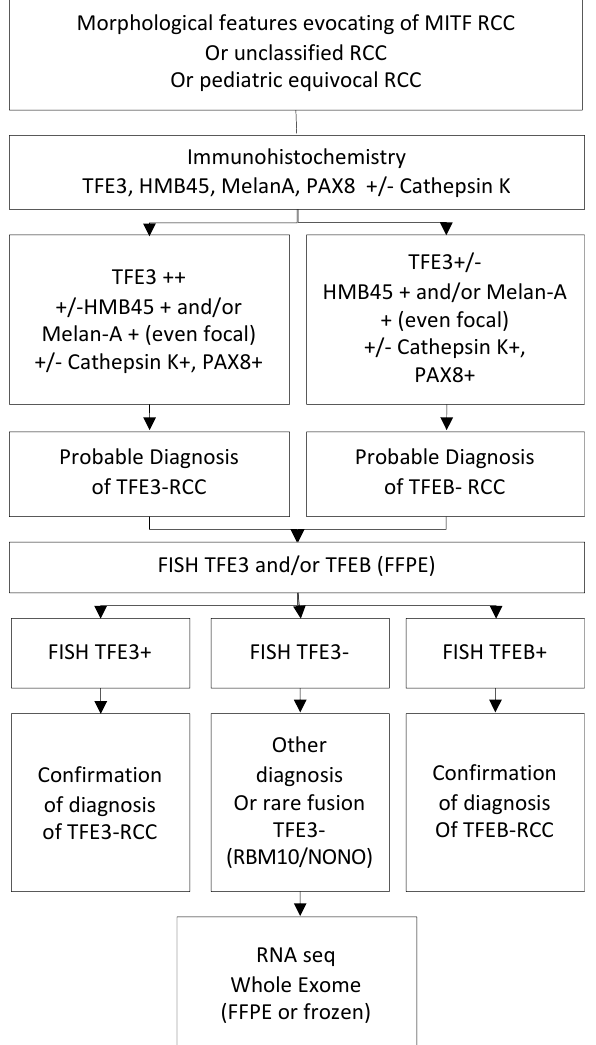
Figure 3. Proposed algorithm of pathologic analyses to identify tRCC; MITF: microphthalmia-associated transcription factor; RCC: translocation renal cell carcinoma; FISH: fluorescence in situ hybridization.